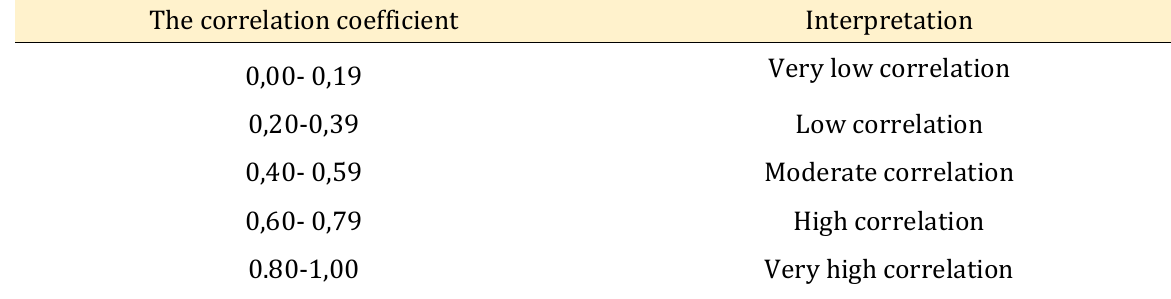
Table 2. The Magnitude of